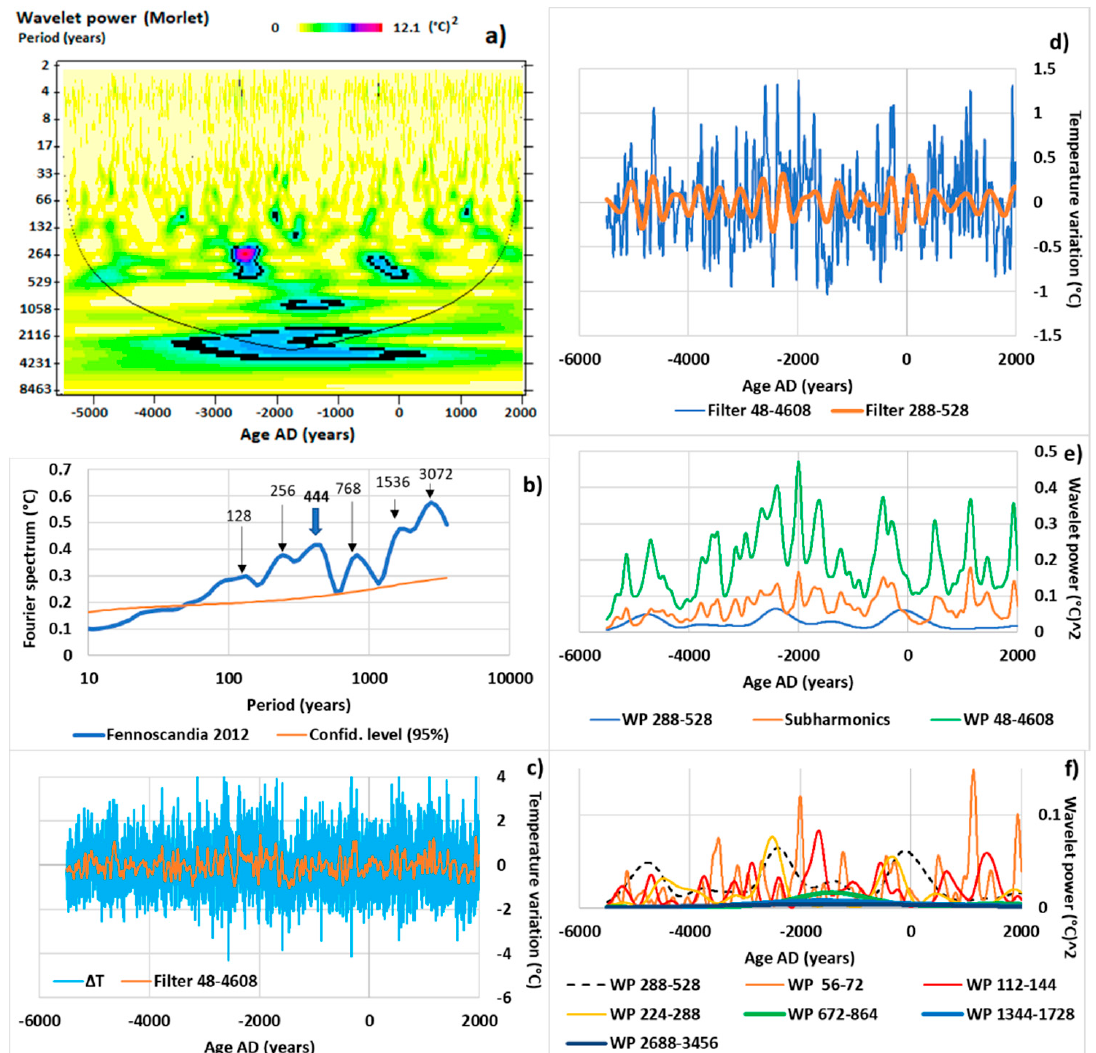
Figure 3. Fennoscandia 7500-years July temperature reconstruction: ( a ) wavelet power and 95% confidence level; ( b ) Fourier spectrum; ( c ) raw and denoised (filtered in the 48–4608-year band) temperature variations; ( d ) temperature variations filtered in the 48–4608 and 288–528-year bands; ( e ) wavelet power (WP) scale-averaged in 288–528 and 48–4608-year bands. Subharmonics are the sum of wavelet powers scale averaged in 56–72, 112–144, 224–288, 672–864, 1344–1728, and 2688–3456 year bands; ( f ) components of the wavelet power scale-averaged in successive bands.